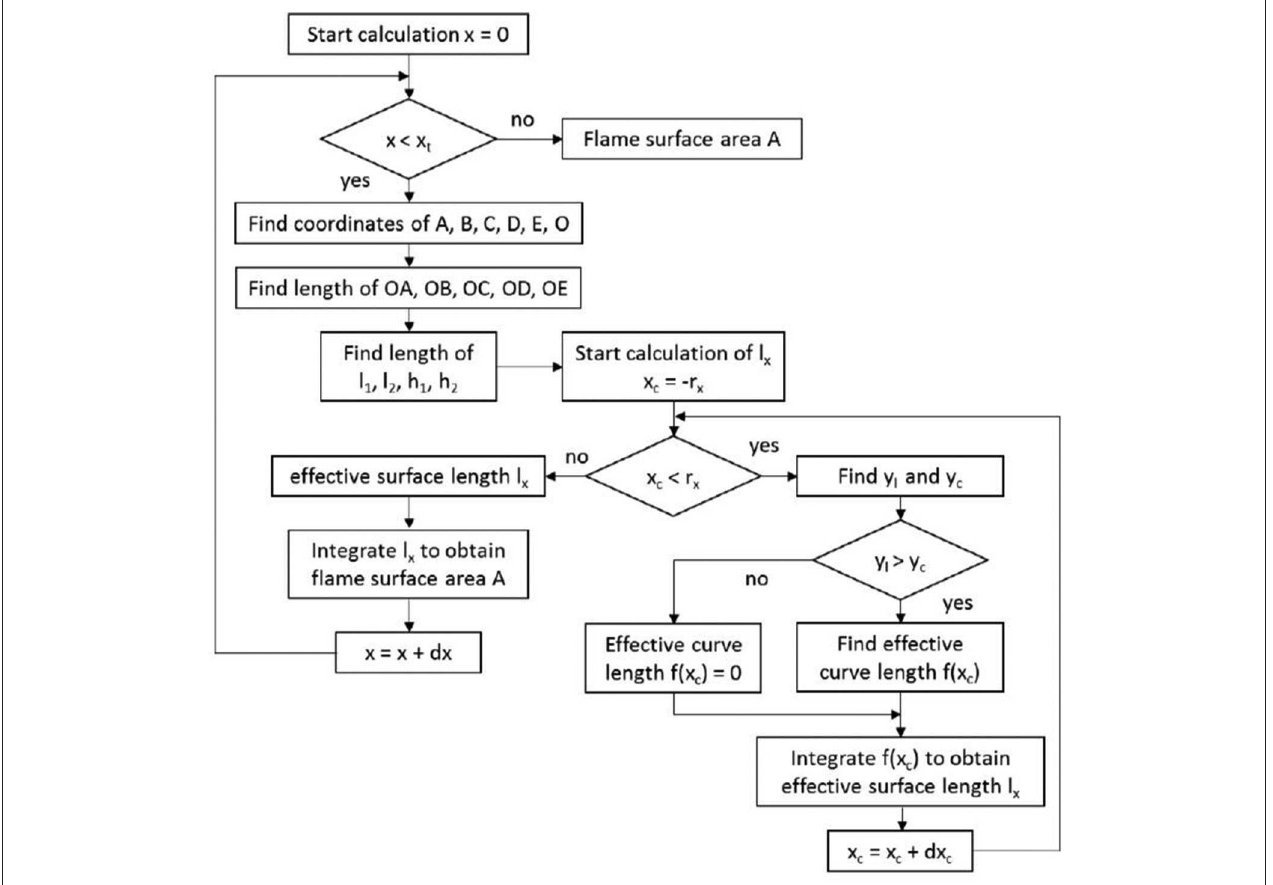
FIGURE 8 | Schematic description of the computing process of flame front